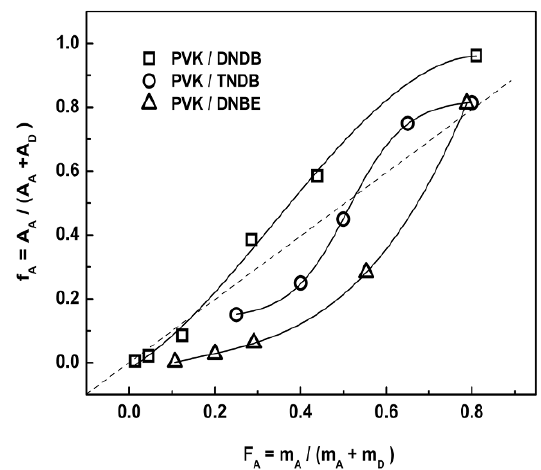
Figure 2. Chromatograms of PVK-DNBE mixtures of different A/D molar ratios.